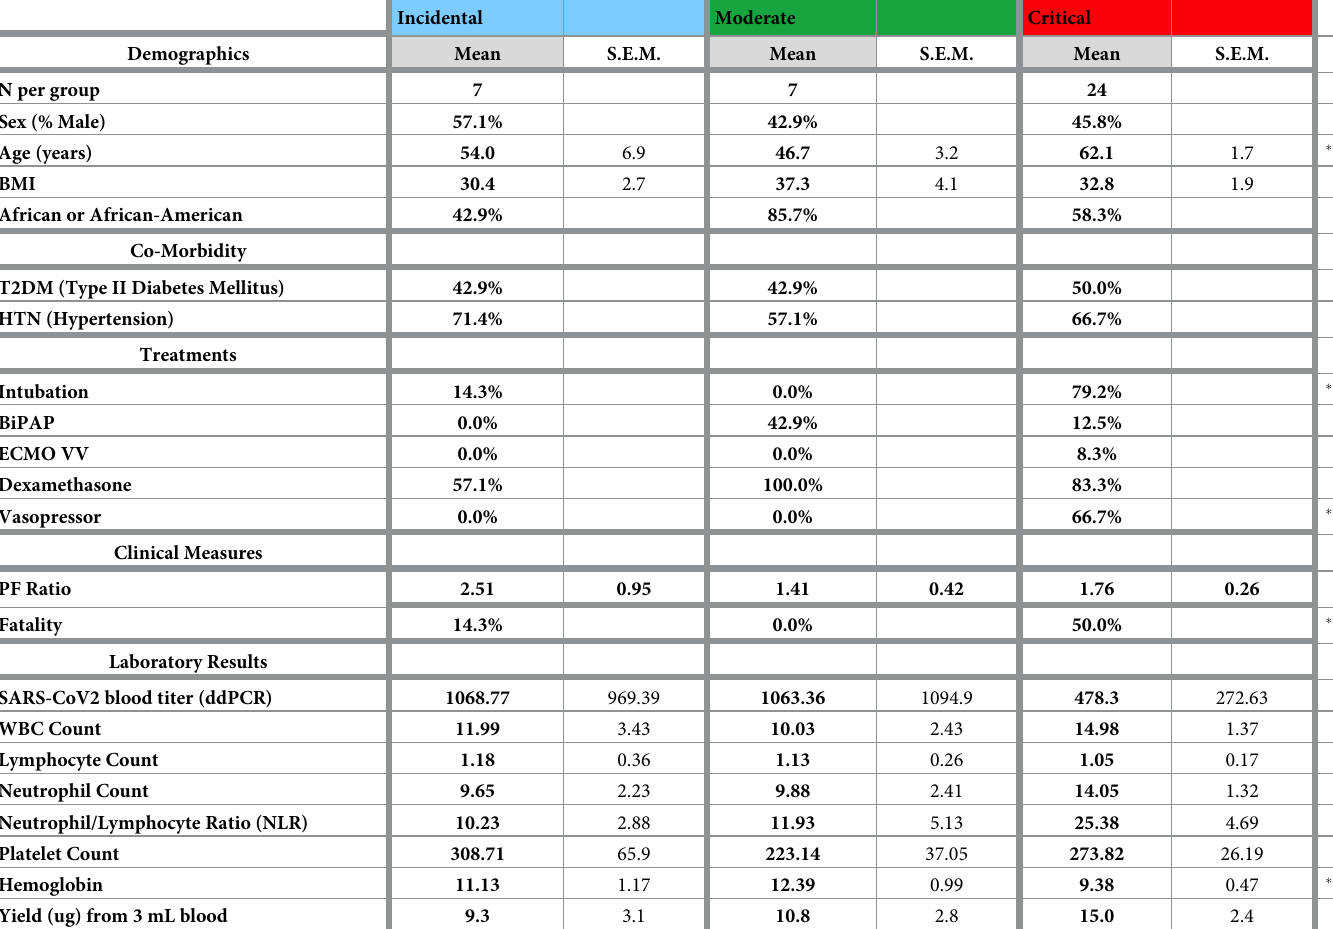
Table 1. Clinical characteristics of ICU patients included in the study. Incidental Moderate